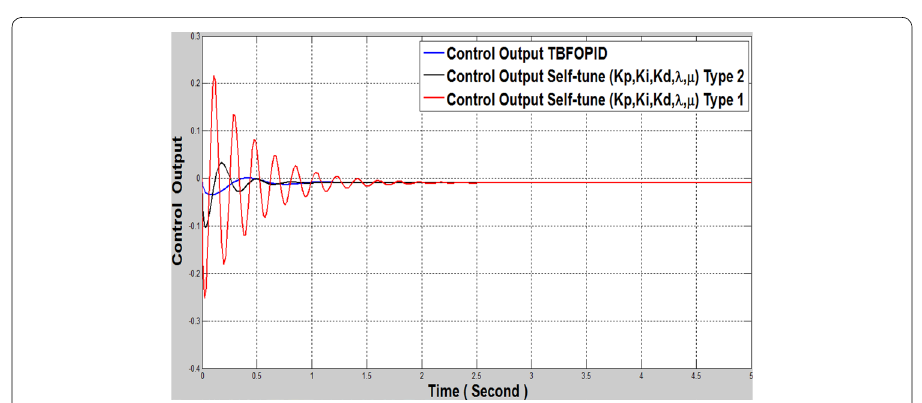
Fig. 29 Controller output via IT2FST and T1FST for TSMFOPID ( k p , k i , k d , λ and μ